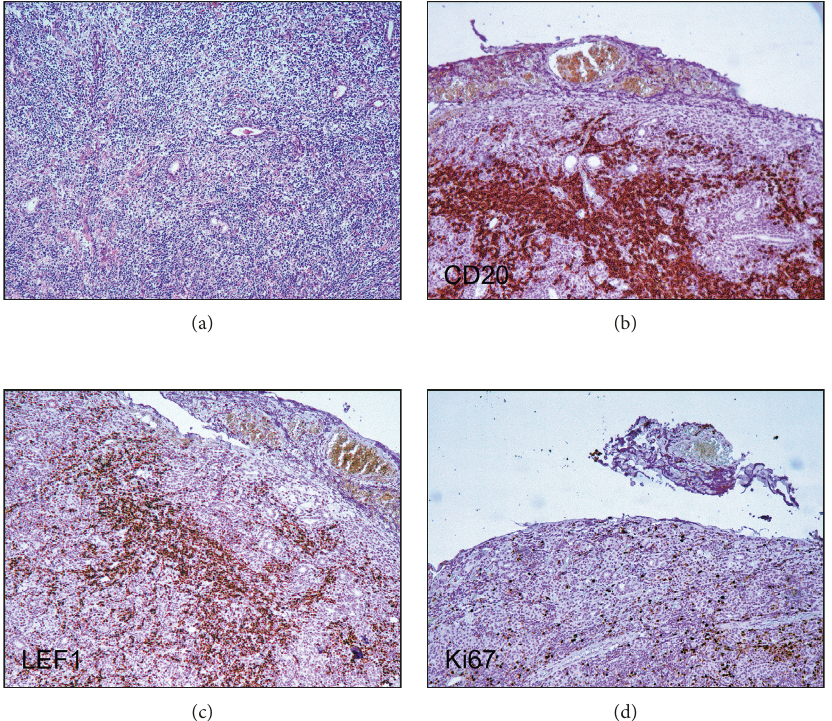
Figure 2: Submandibular salivary gland. (a) The architecture of the submandibular salivary gland is replaced by a diffuse small lymphocyte infiltrate H&E staining, × 100. (b) The SLL component strongly expresses CD20, highlighting focal accumulations of CD20+ B cells, × 100. (c) B cells express LEF1, × 100. (d) Proliferative activity marker Ki-67 in the B-cell area is expressed by up to 20% of the cells, ×